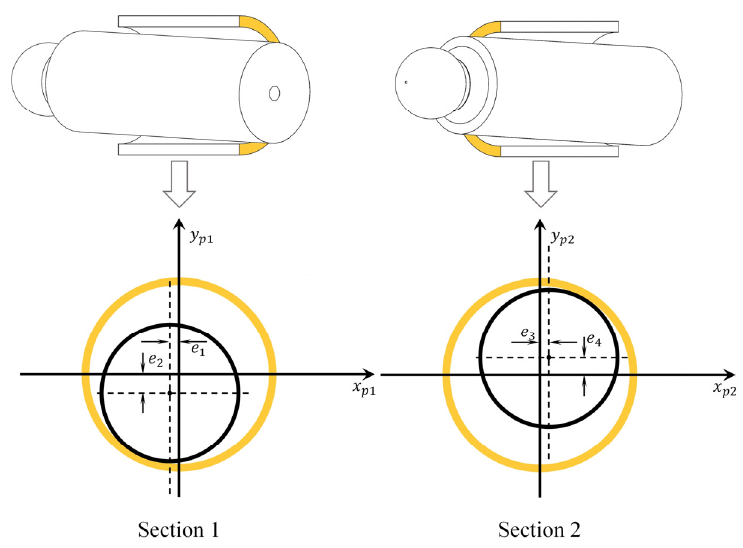
Figure 1. The inclined piston in the cylinder.